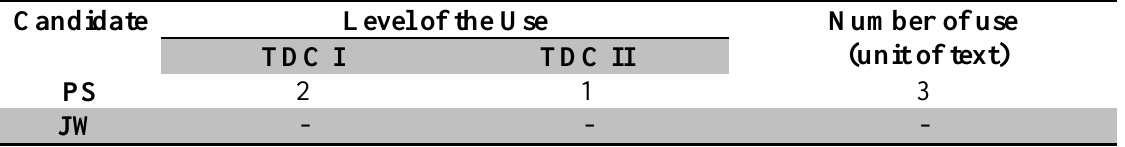
Table 4.3: Level of the Use of Zig-zag Pattern by Both Presidential Candidates